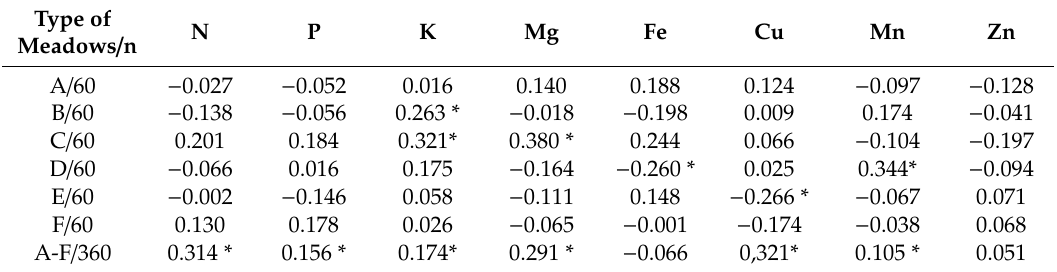
Soil–sward relationship (Pearson correlation value) in respect to macro- and micro mineral